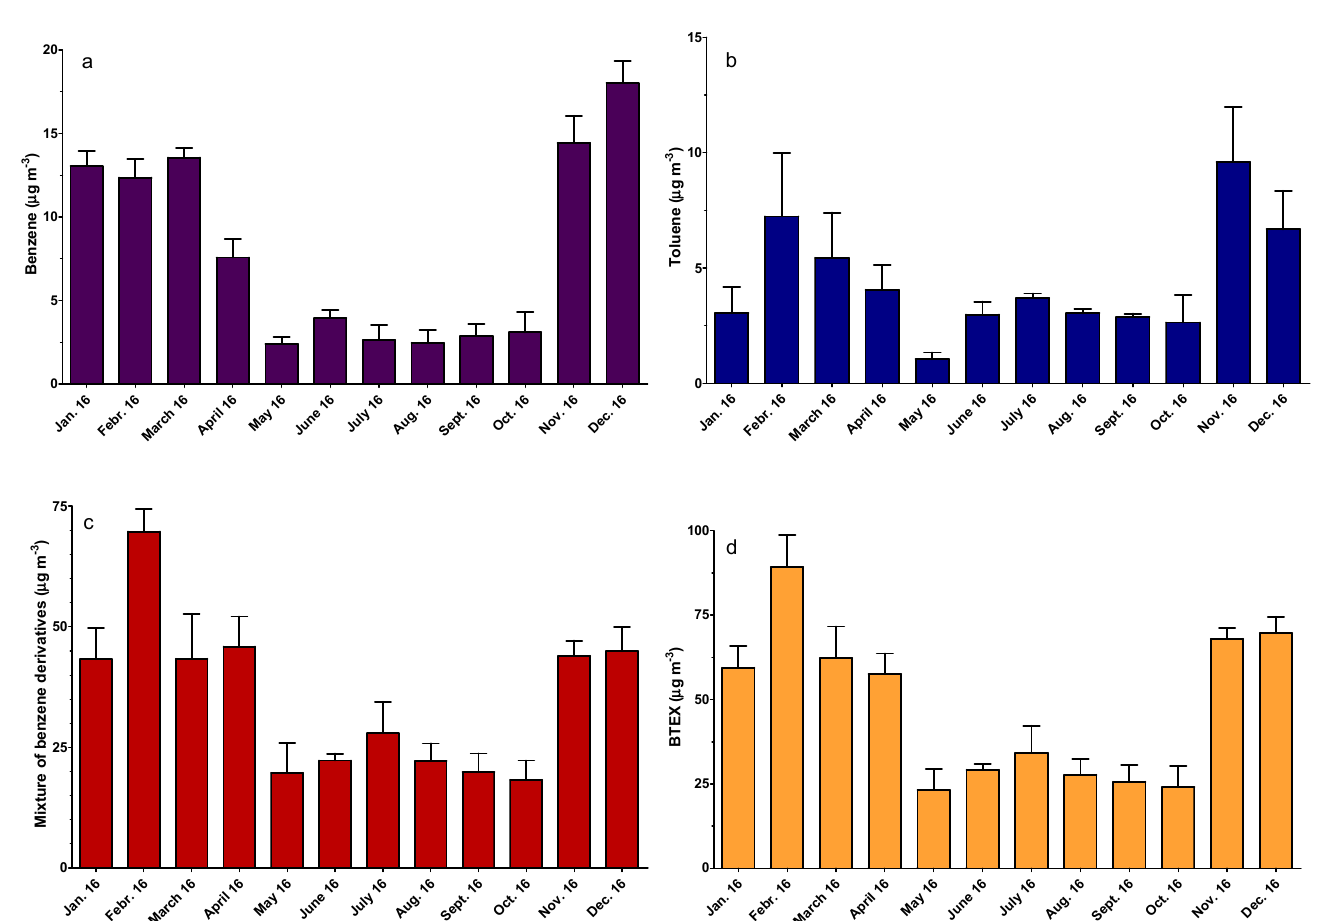
Figure 2. Monthly variations in benzene ( a ), toluene ( b ), benzene derivatives (o-, p-xylene, and ethylbenzene) ( c ), and total BTEX ( d ).